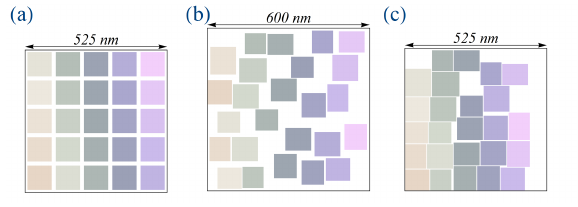
Figure 1. Examples of 25 nanoplatelets assemblies numerically generated. (a) Ordered assembly on a periodic square array. Dis- ordered assemblies with a surface content ϕ s = 56% (b) and ϕ s = 81% (c). The color code is only for esthetic purpose.